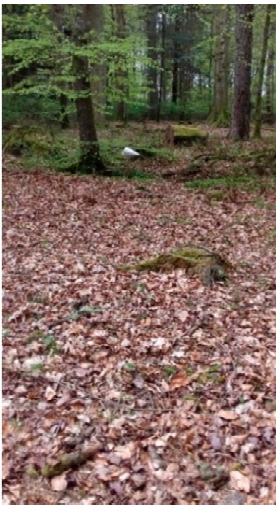
Figure 3. Extending Practice Sessions at the Haining and Bowhill Woods. Image, author’s own.